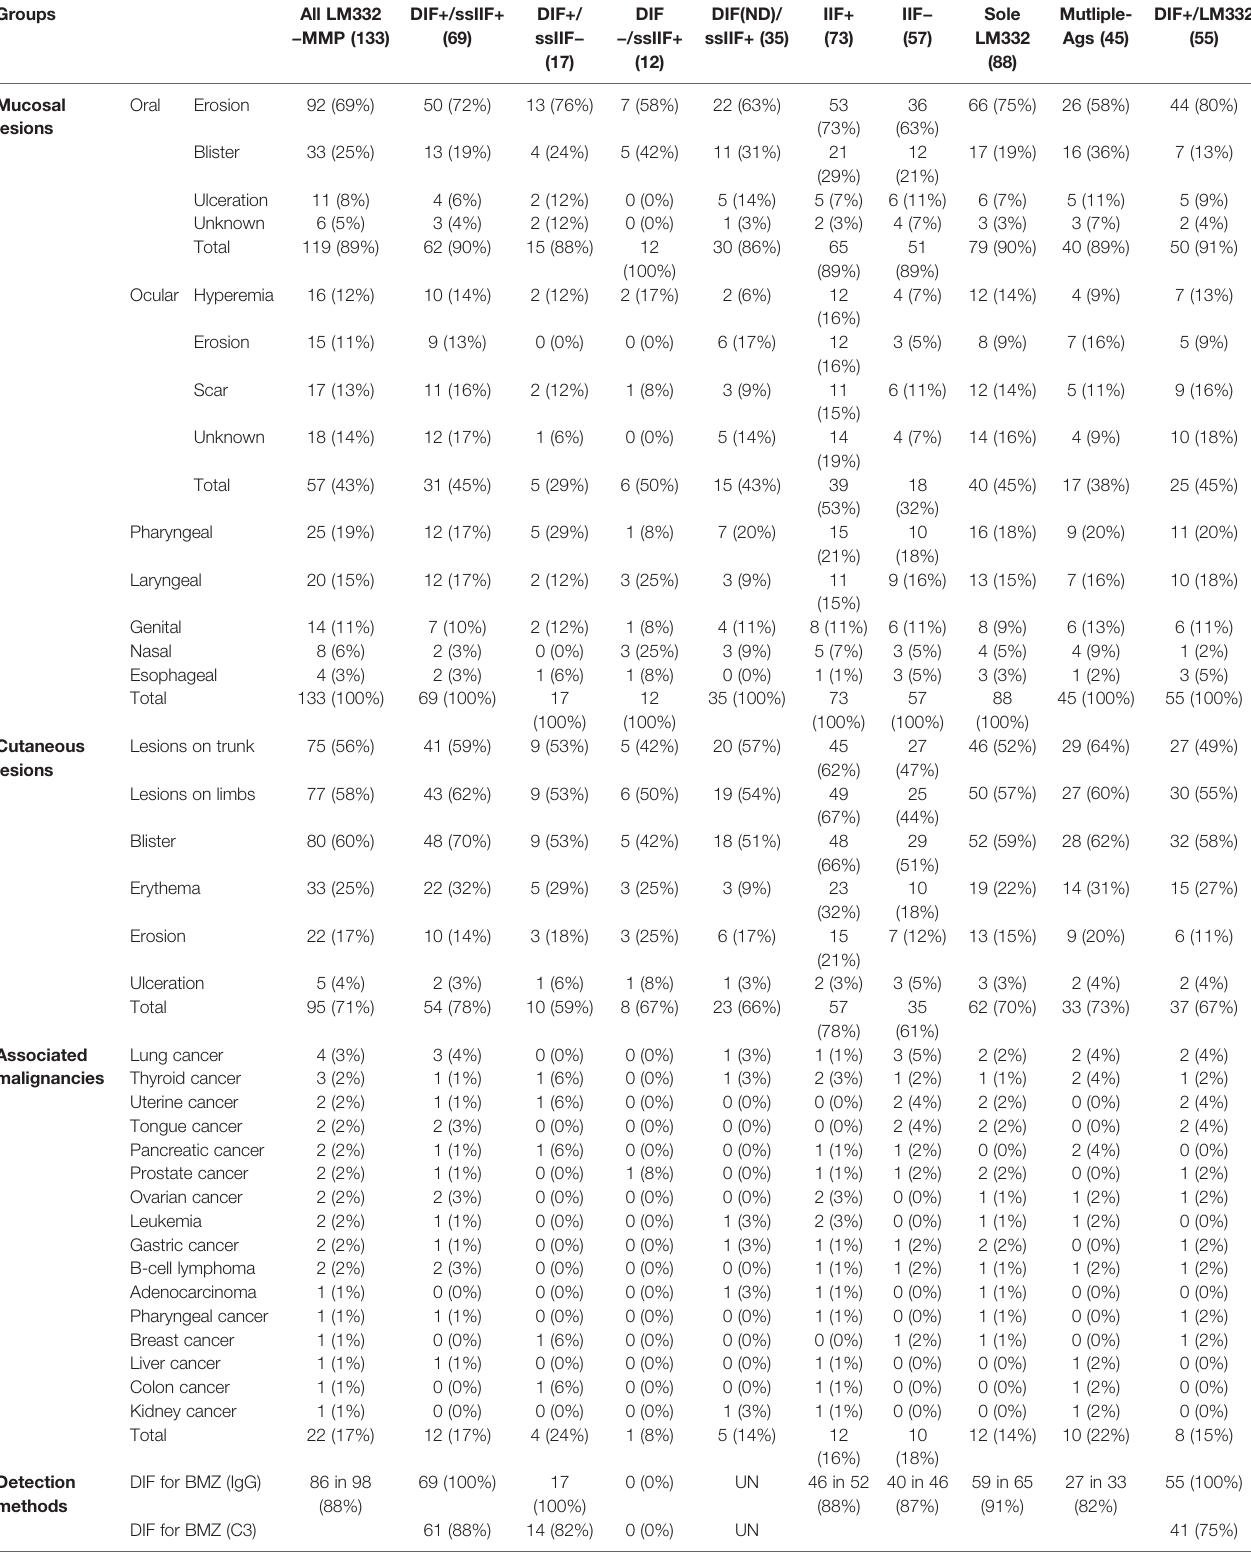
TABLE 1 | Clinical and immunological fi ndings in 133 patients with anti-laminin (LM) 332-type mucous membrane pemphigoid (MMP). Groups